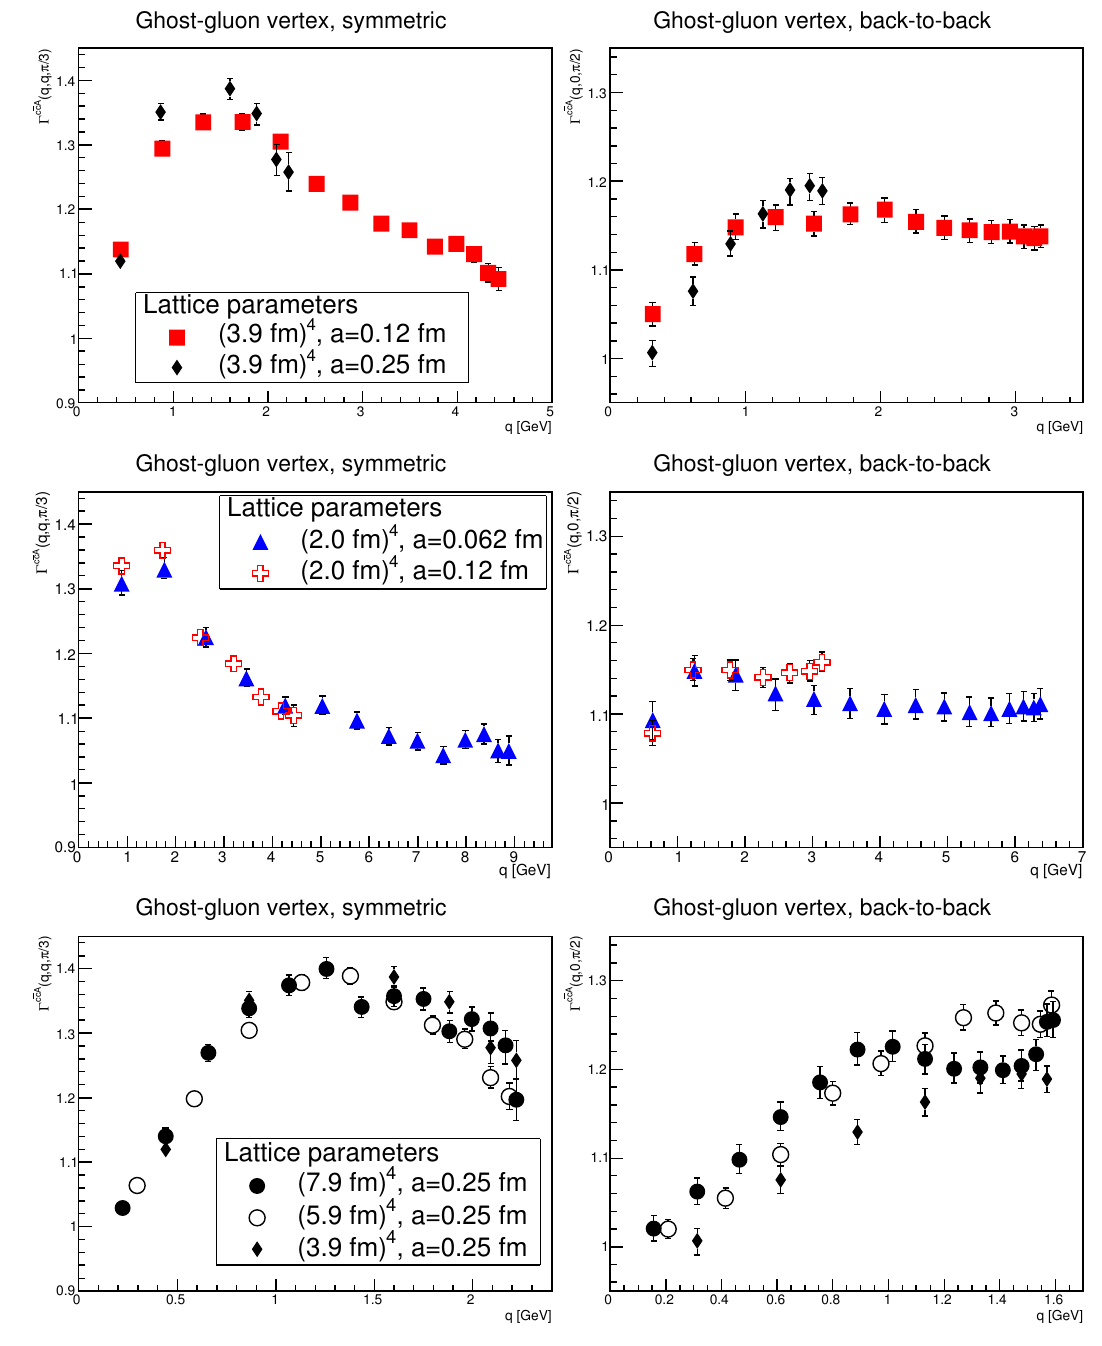
Figure 8: The systematic dependence on the lattice parameters for the ghost-gluon vertex in four dimensions. The left panels show the symmetric momentum configu- ration and the right panels the back-to-back momentum configuration. The top and middle panels show two cases with fixed physical volume and changing discretization and the bottom panel a case at fixed discretization and changing physical